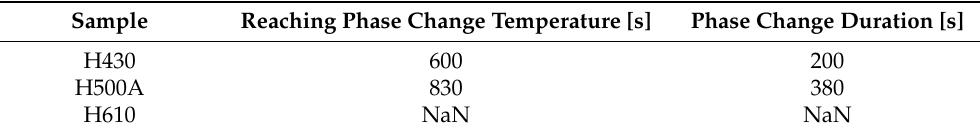
Figure 10. TESS charging under full load conditions. Table 3. TESS charging time for varying PCM samples (full load).